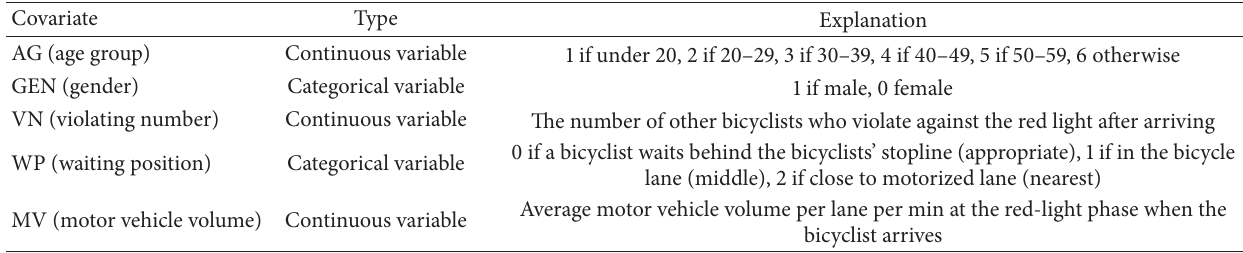
Table 1: Covariates selection and explanation.